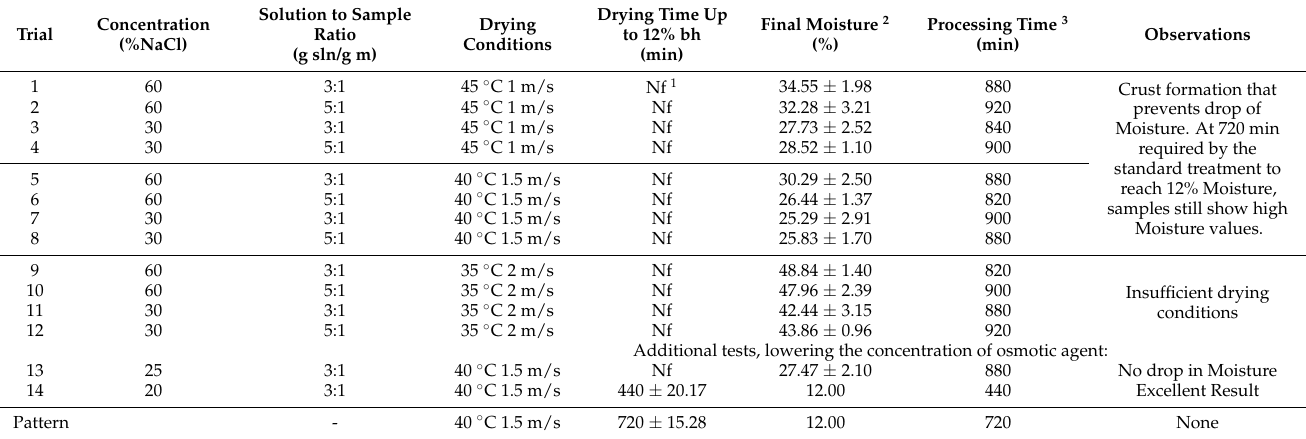
Table 4. Tests with adjusted OD parameters as pretreatment of convective